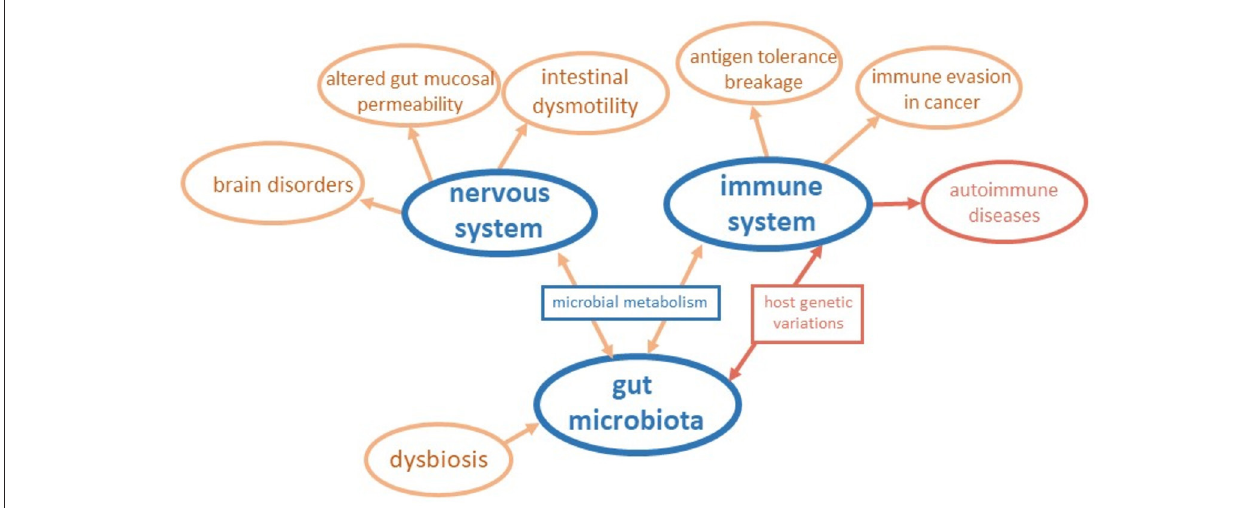
FIGURE 1 | Schematic representation of insights coming from contributions to the Research Topic. The connections among the gut microbiota, the nervous system, and the immune system are outlined considering the main results of papers of the Research